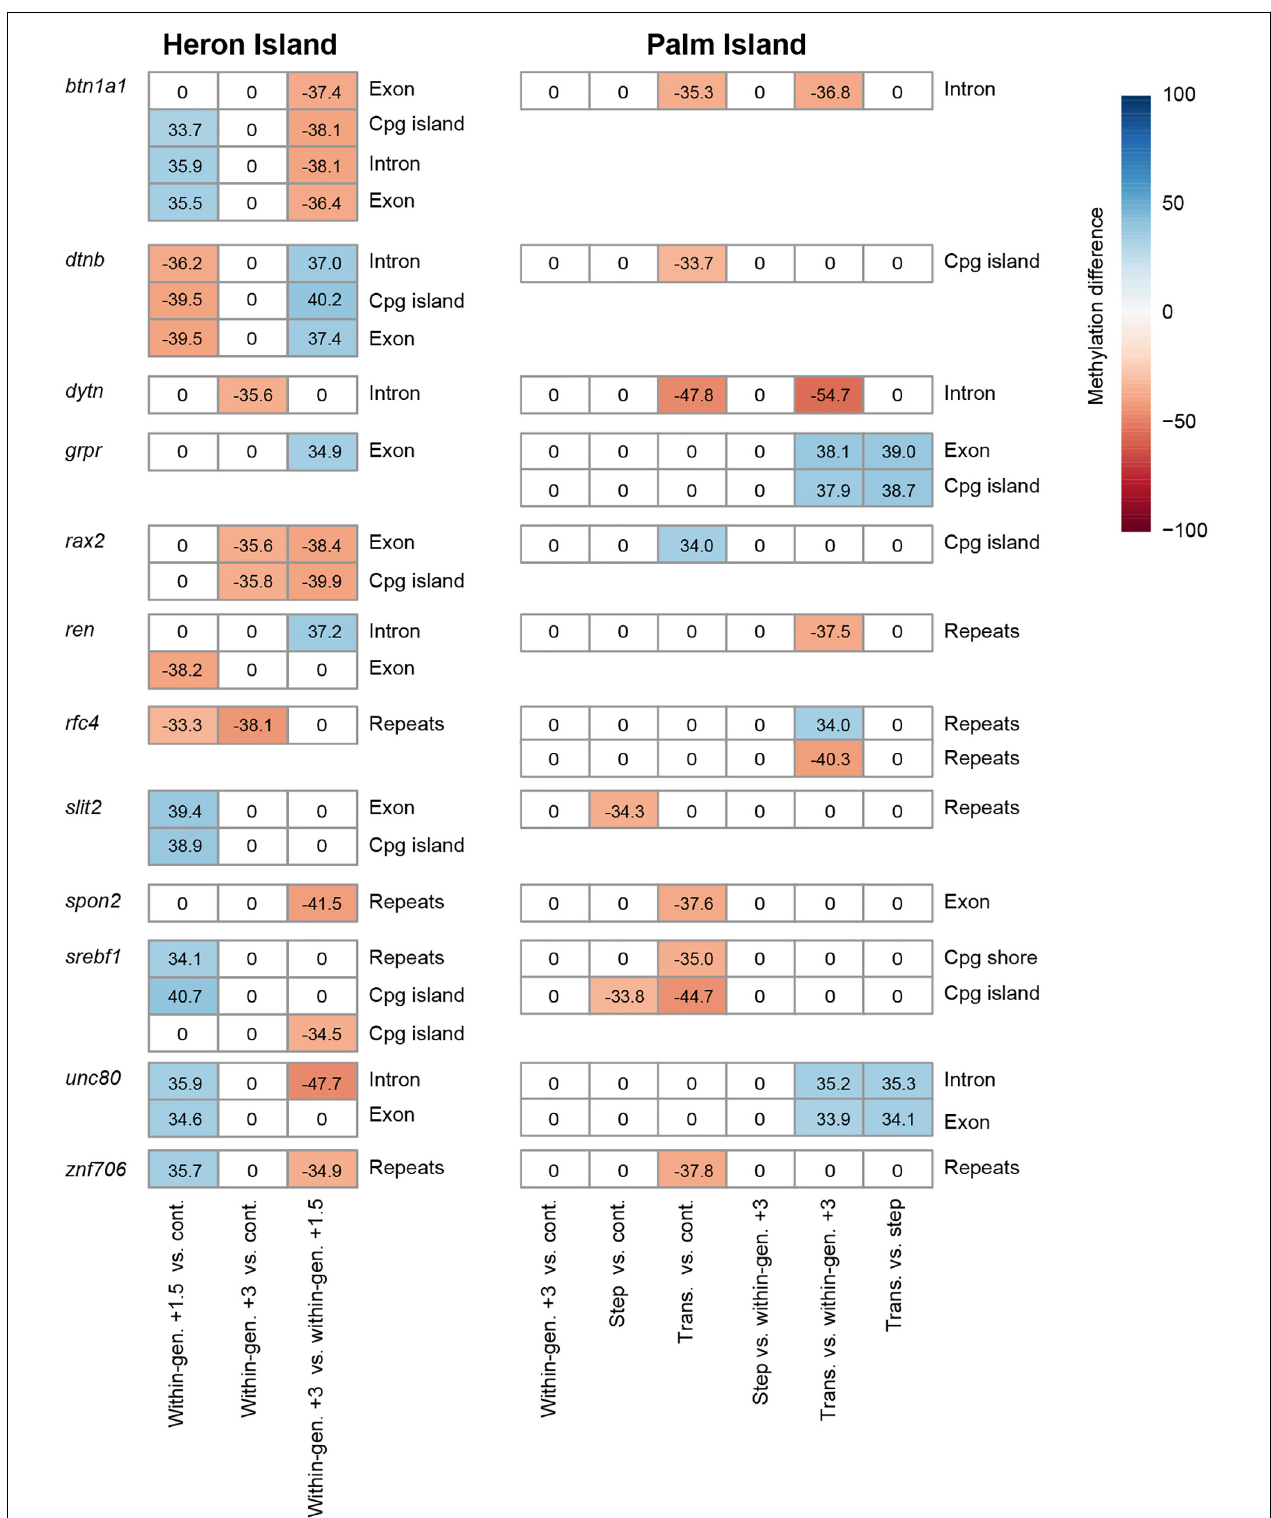
FIGURE 4 | Common DMR genes in Heron and Palm populations. These 12 genes may be involved in both within- and between-generational plasticity to elevated temperatures. Each row and column correspond to one DMR and comparison of two treatments, respectively. The colors and values indicate the percentage differences of methylation level of genomic regions. Methylation differences for non-DMRs are represented as zero.